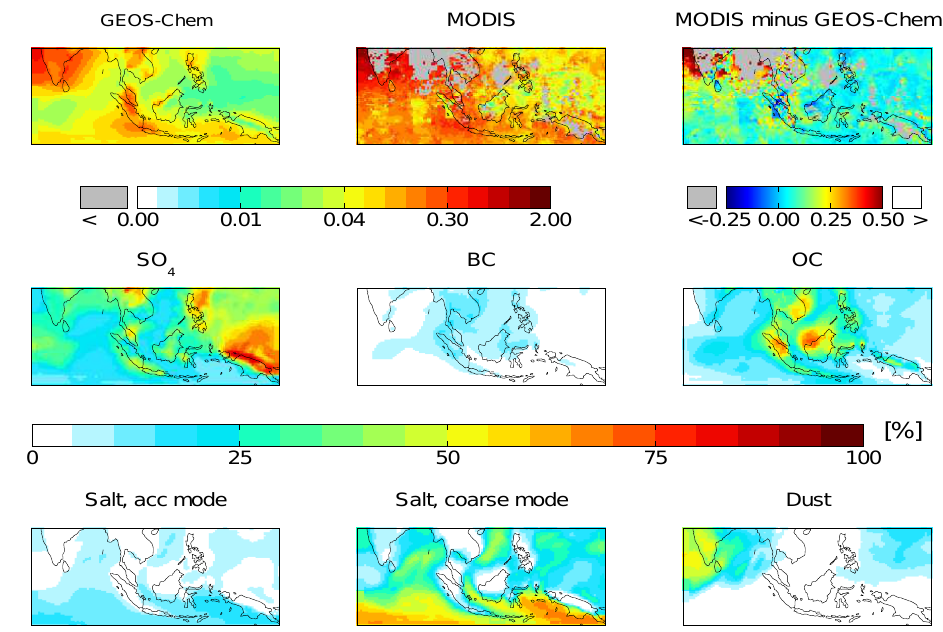
Fig. 3. MODIS and GEOS-Chem model aerosol optical depths [unitless] and their differences for July 2008. The model has been sampled at the same time and location as the observations. Contributions to the model AOD from SO 2 − sea salt (accumulation and coarse modes), and desert